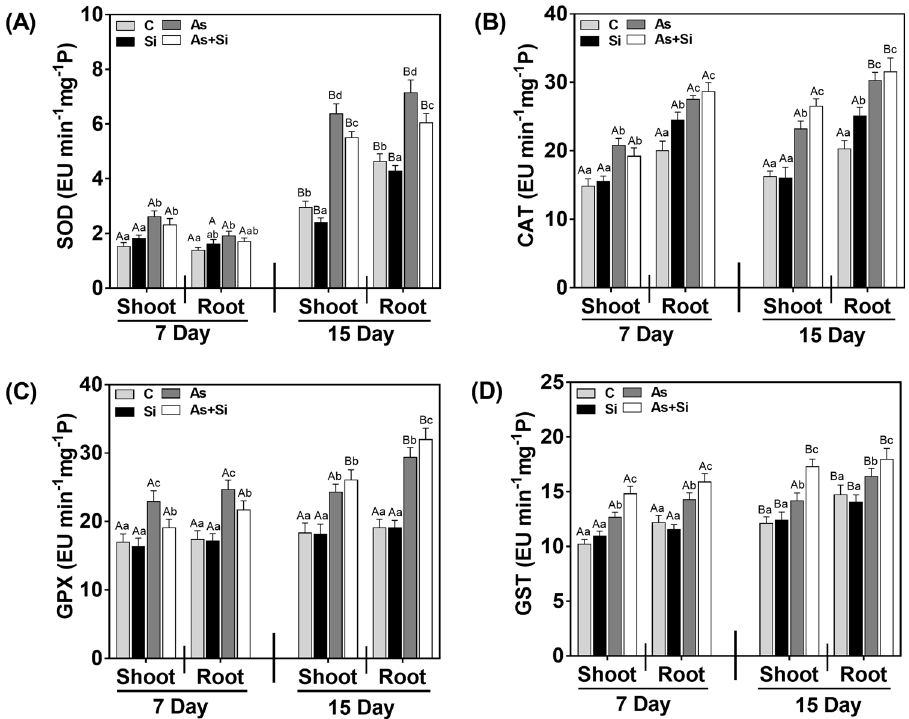
Figure 7. Effect of Si, As (III) , and As (III) + Si on ( A ) SOD ( B ) CAT ( C ) GPX and ( D ) GST activity in shoot and roots of Oryza sativa var. IR64 at 7 and 15 d. All values are means of three replicates (n = 3, ± SD) and repeated twice. Different letters indicate the significant mean difference ( p < 0.05) between each treatment. The small latter (i.e. a, b, c and d) indicates the significant difference between treatment in same tissue type while capital latter (i.e. A and B) indicates the significant difference between duration among the same treatment in same tissue